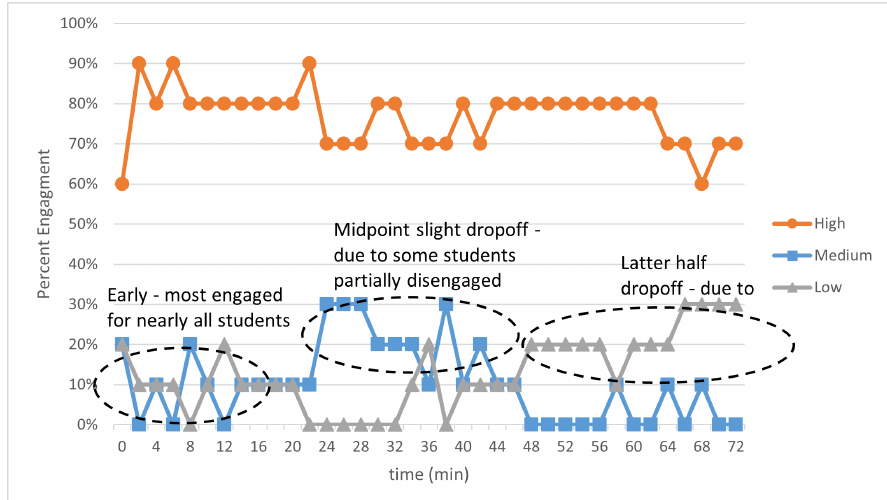
Figure 9. Dictionary of Tokens.